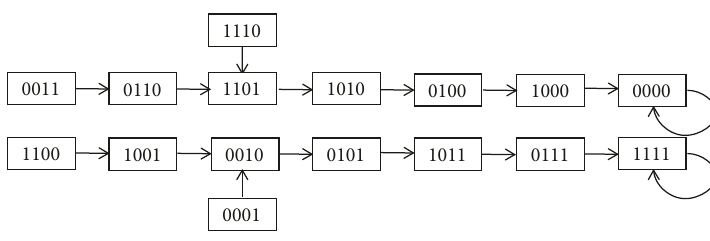
Figure 8: State diagram of NFSR with the feedback functions 𝑓 󸀠 in Example 32.